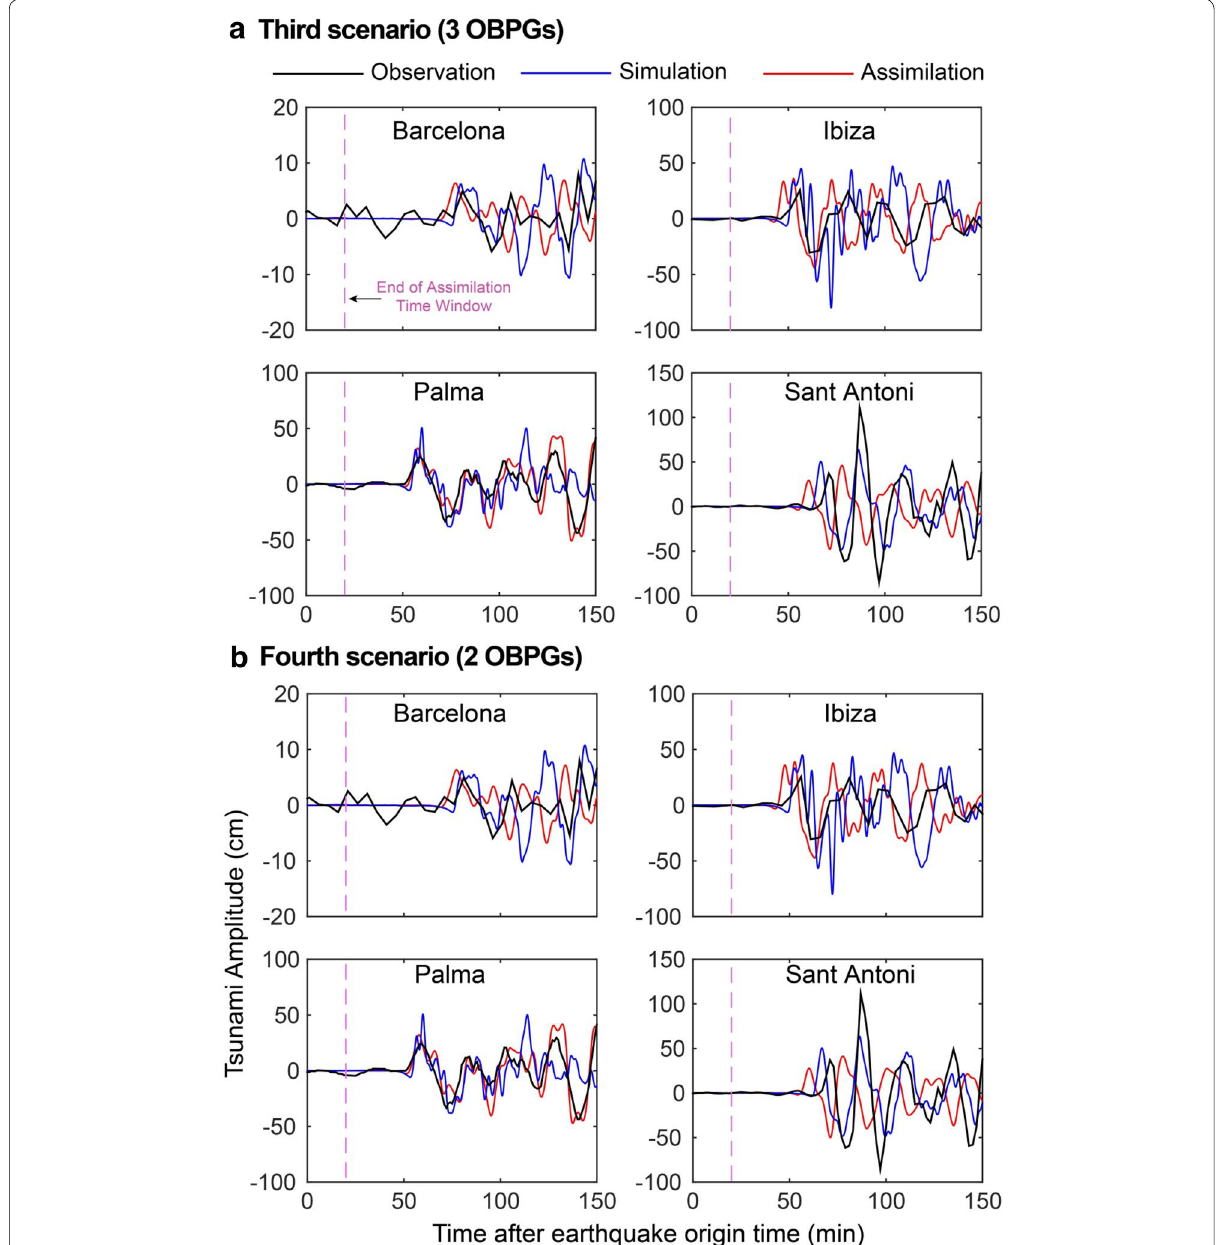
Fig. 7 Comparison of the observations (black lines), simulation (blue lines) and forecasted (data assimilation; red lines) waveforms at four PoIs for the third ( a ; three OBPGs) and fourth ( b ; two OBPGs) scenarios. The time window for assimilation is 20 min (dashed vertical